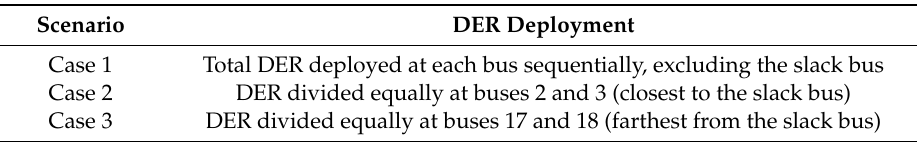
Table 3. DER deployment